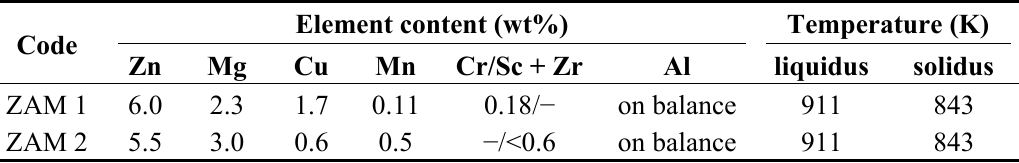
Table 1. Elementary composition of AlZnMg matrix